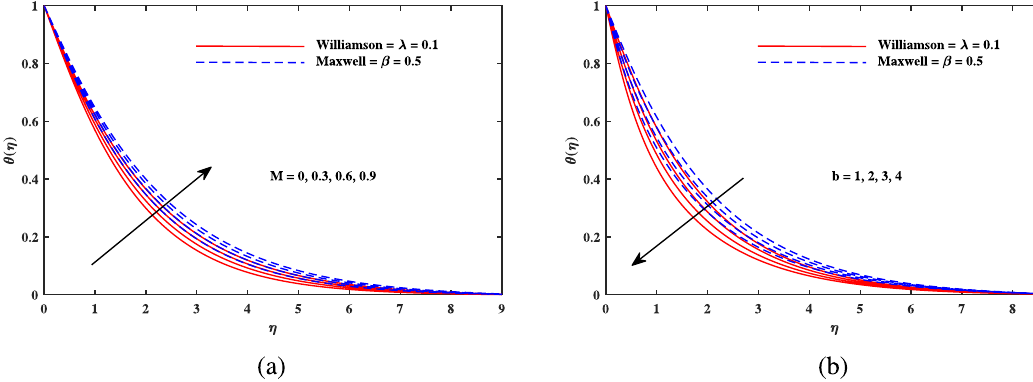
Figure 4. Temperature θ(η) fluctuation with of ( a ) M and ( b ) b .